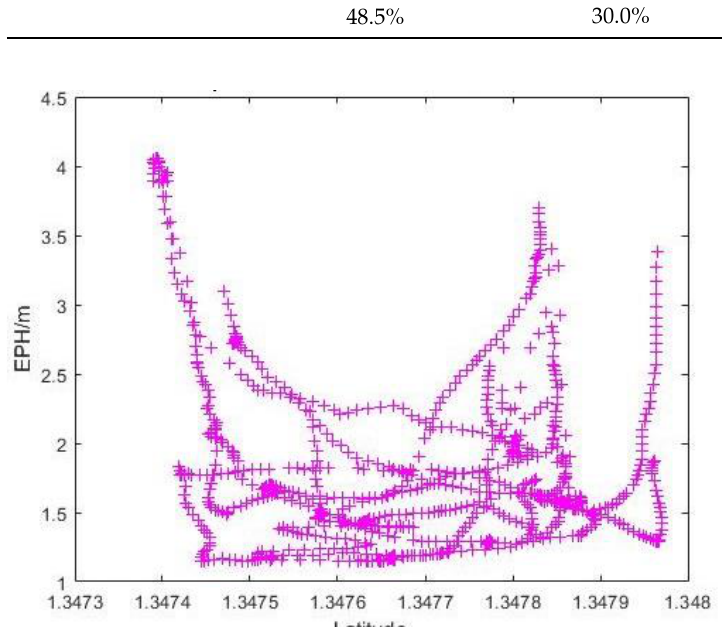
Figure 17. Graph of EPH vs. Latitudinal Value at N3.1.